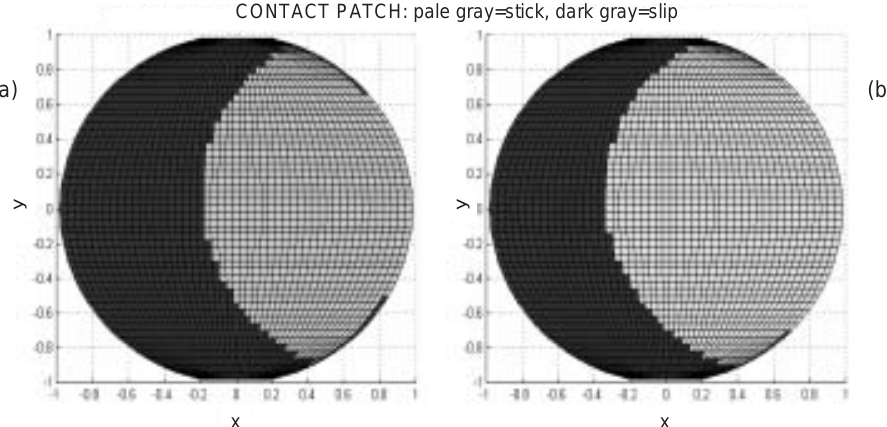
Fig. 9. Adimensionalized contact patches taken into account by FASTSIM for the computation of the tangent contact forces. The contribution of the bogie weight is taken into account. (a) Vehicle on rails; (b) vehicle on